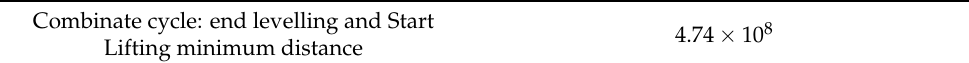
Table 11. Number of cycles at the maximum stress for the combinate cycles (R = 0.3) for the stick arm. Combinate cycle: end levelling and Start